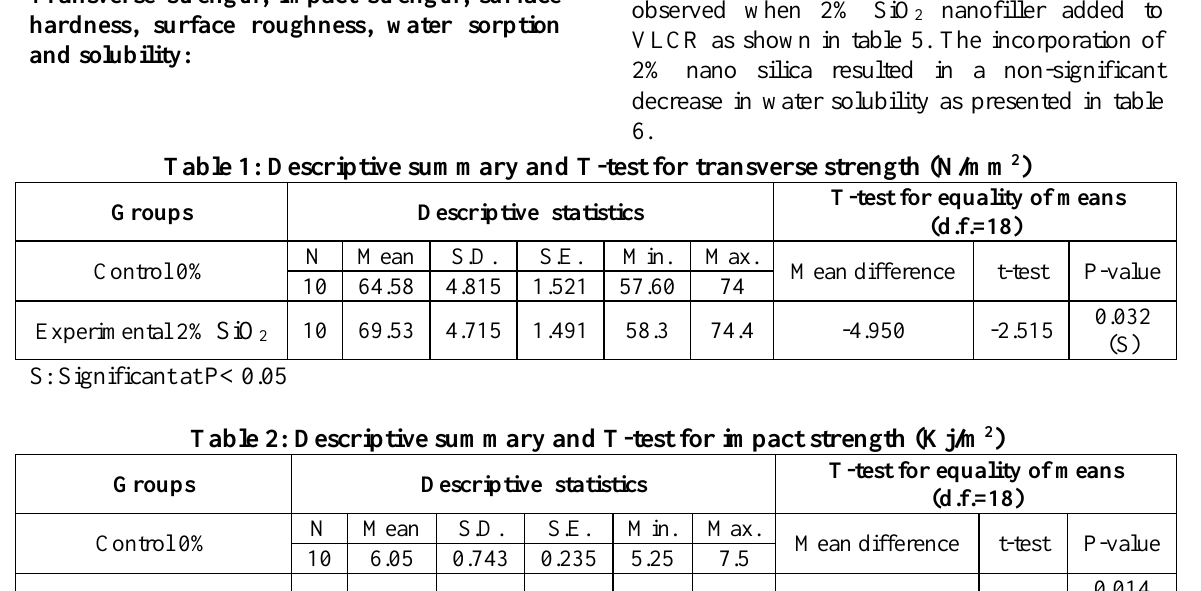
Table 3: Descriptive summary and T-test for surface hardness